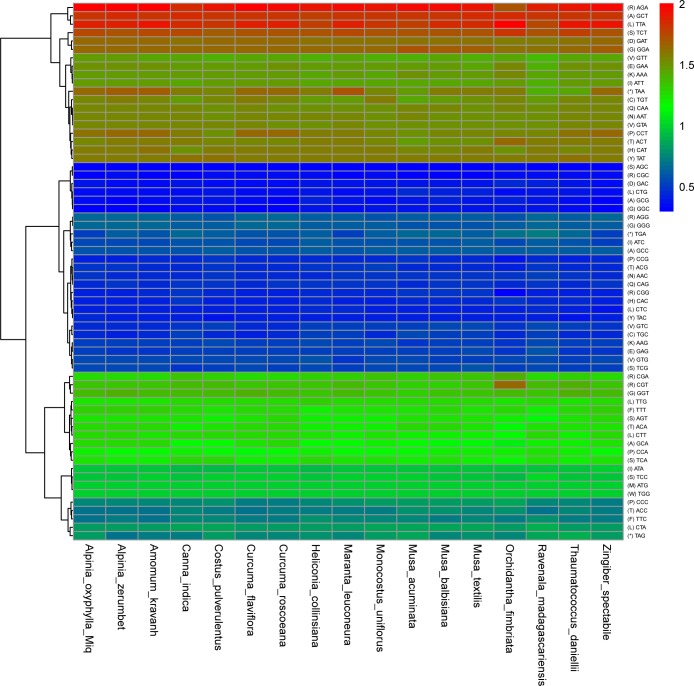
Heatmap analysis for codon distribution of all protein-coding genes of all considered species.Colour key: higher red values indicate higher RSCU values, and lower blue values indicate lower RSCU values.